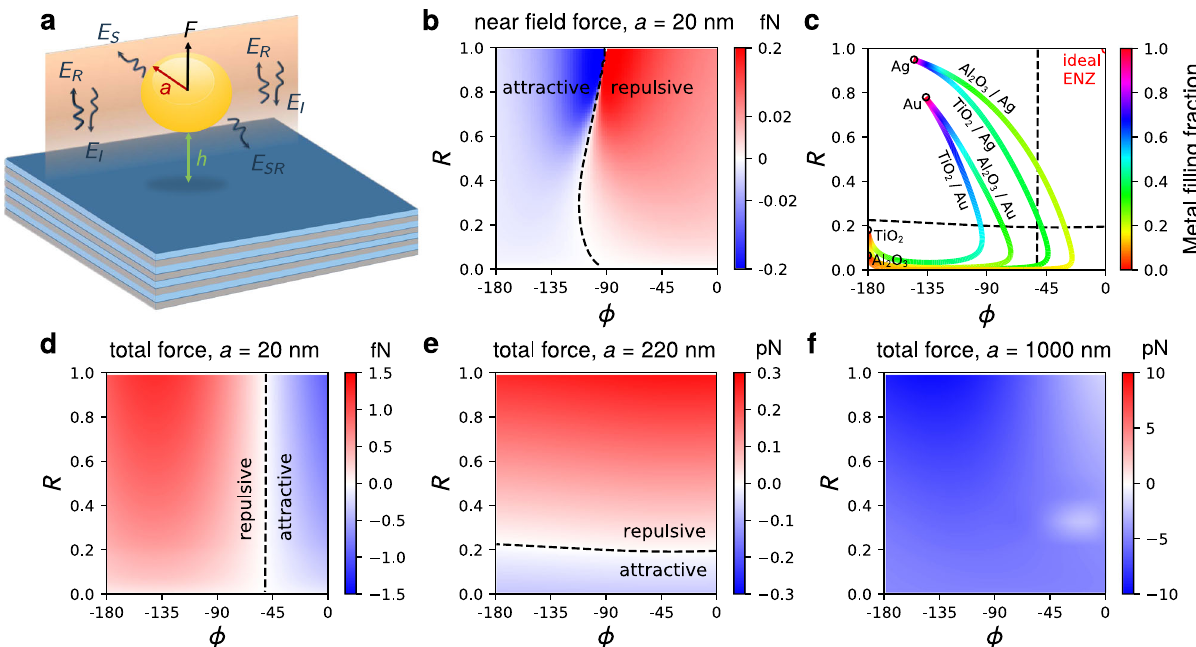
Fig. 1 Geometry and optical force parameter space maps. a Sketch of the geometry. We consider a generic particle, in principle of any shape and composition, in front of a metamaterial surface at an edge-to-edge distance, h , immersed in an external medium (e.g., water) of refractive index n m . The origin of the coordinate system is placed on the surface so that the z axis is positive in the semi-in fi nite space where the particle resides. A monochromatic optical wave illuminates the particle and surface at normal incidence so that the total fi eld is the superposition of incident ( E I ), re fl ected ( E R ) and scattered fi elds ( E E fi eld force ( R , ϕ ) map. We explore the range of S , SR ). The resulting optical force can be either attractive (negative) or repulsive (positive). b Near- re fl ectivity, R , and phase, ϕ , related to the re fl ection of the incident wave on a generic surface. The ideal ENZ surface ( R = 1, ϕ = 0)) is in the top right corner of the map and shows a repulsive force. Here, the near- fi eld force component is calculated in the dipole approximation for a polystyrene (dielectric constant ε p = 2.543 at 560 nm)) particle of radius a = 20 nm at a fi xed edge-to-edge distance of h = 10 nm in water. c Curves of ( R , ϕ ) for different substrates consisting of alternating metal and dielectric layers, in the thin layer limit where effective medium theory is valid. The color of each curve indicates the metal fi lling fraction. The zero-force lines from panels d and e are superimposed as dashed lines. d – f Total force ( R , ϕ ) maps as calculated from T-matrix methods for a dielectric particle size of a = 20 nm ( d ), a = 220 nm ( e ), and a = 1000 nm ( f ), respectively, and at a fi xed h = 10 nm. The total force maps have a structure that is strongly dependent on particle size. This is due to the increase of the scattering force component that, for large particles, overcomes any other gradient-like force component that is dominant for